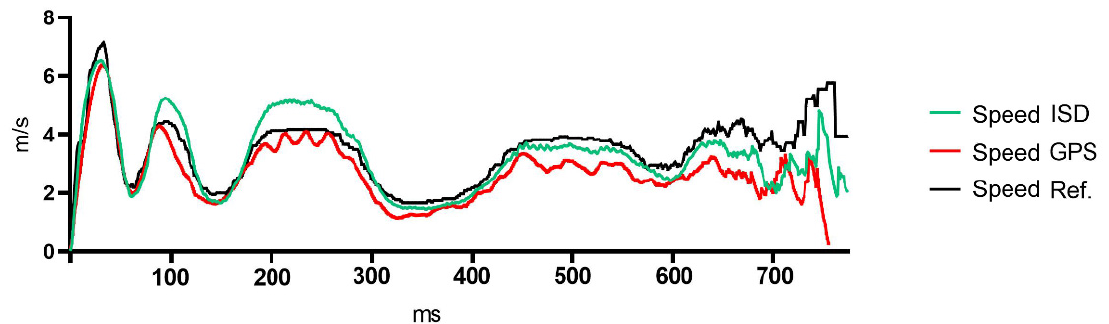
Figure 2. Aggregated data for ISD, GPS and reference system during soccer specific circuit. Accelerations and decelerations are observed during sprints and change of directions, respectively.